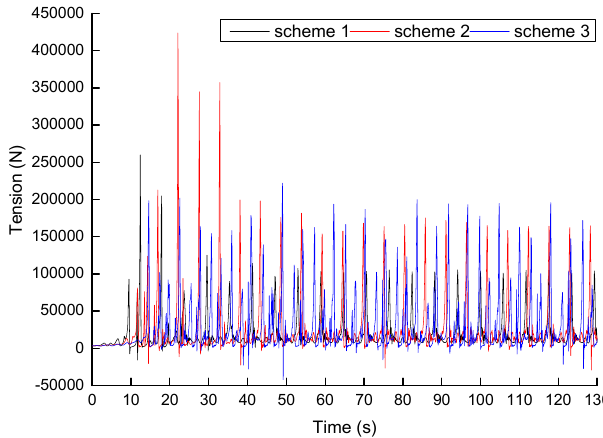
Figure 7. The stress of anchor chain 2 in schemes 1, 2, and 3. Anchor chains 3 and 4 are also symmetrically laid out, so the stress changes of the two chains are also similar, as shown in Figures 8 and 9. Floating of the device becomes stable after 30 s. The stress of the two chains in scheme 1 varies greatly, whereas their stress in scheme 3 varies moderately, and their stress in scheme 2 barely varies.